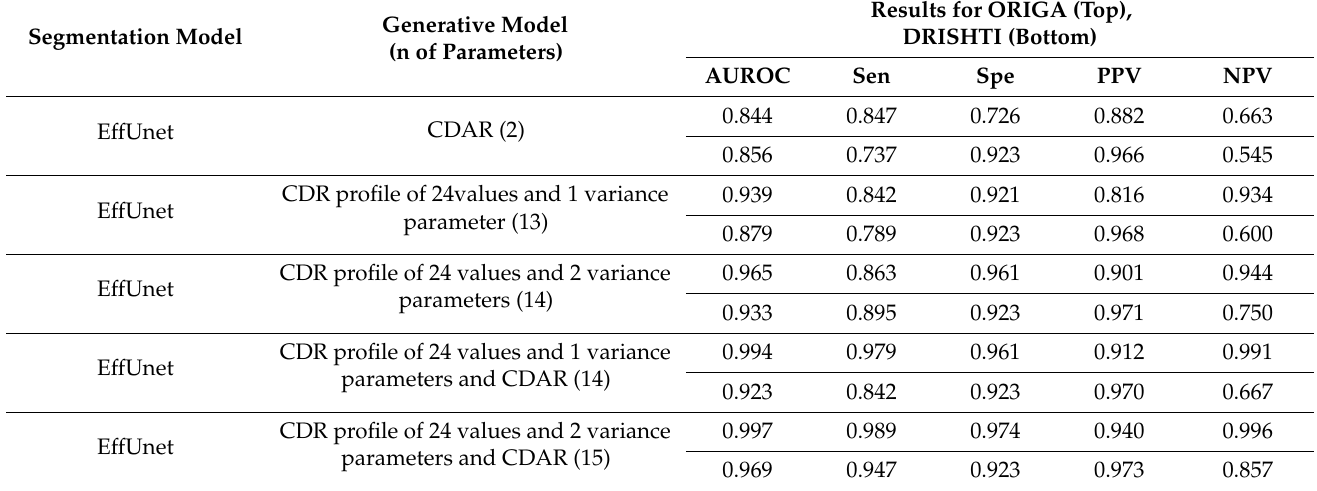
Table 5. Ablation study of accuracy of EffUnet-SpaGen in internal validation on ORIGA and on DRISHTI. For ORIGA: train set for segmentation and glaucoma detection is ORIGA-A (n = 325) (253:72 of healthy: glaucomatous), test set is ORIGA-B (n = 325) (229:96 of healthy: glaucomatous). For DRISHTI: train set for segmentation is whole ORIGA and DRISHTI-A, train set for glaucoma detection is ORIGA and test is DRISTHI-B. CDAR is the Cup/Disc Area Ratio.